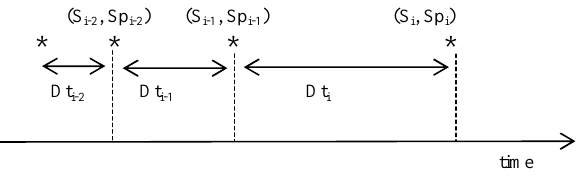
Figure 5. Schematic representation of the seismic process of occurrences. 11 Fig. 5. Schematic representation of the seismic process of occur- rences.